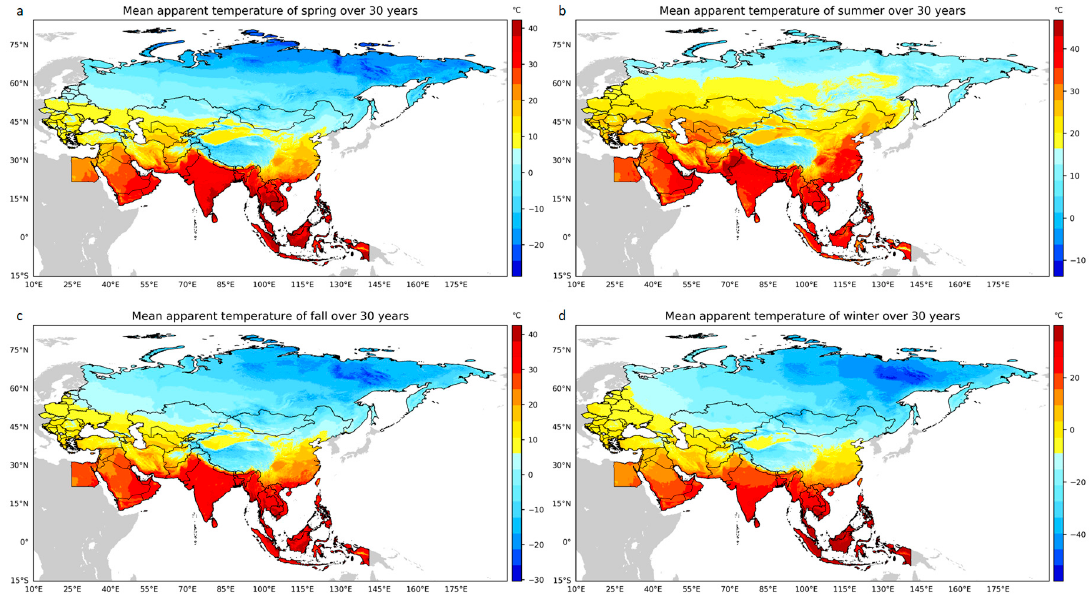
Figure 5. Spatial distribution of mean apparent temperature between 1989–2018 for: ( a ) spring, ( b ) summer, ( c ) autumn, ( d ) winter.